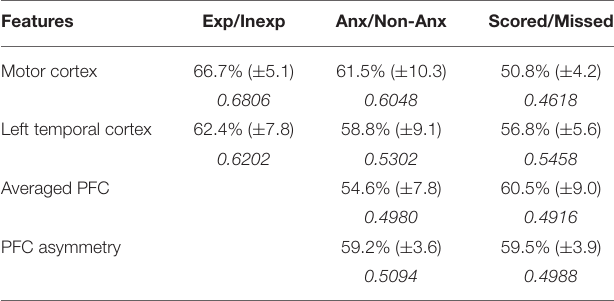
TABLE 3 | Mean accuracy, standard deviation (in brackets), and area under the ROC (in italic style) of SVM-based classification from five runs using a different type of